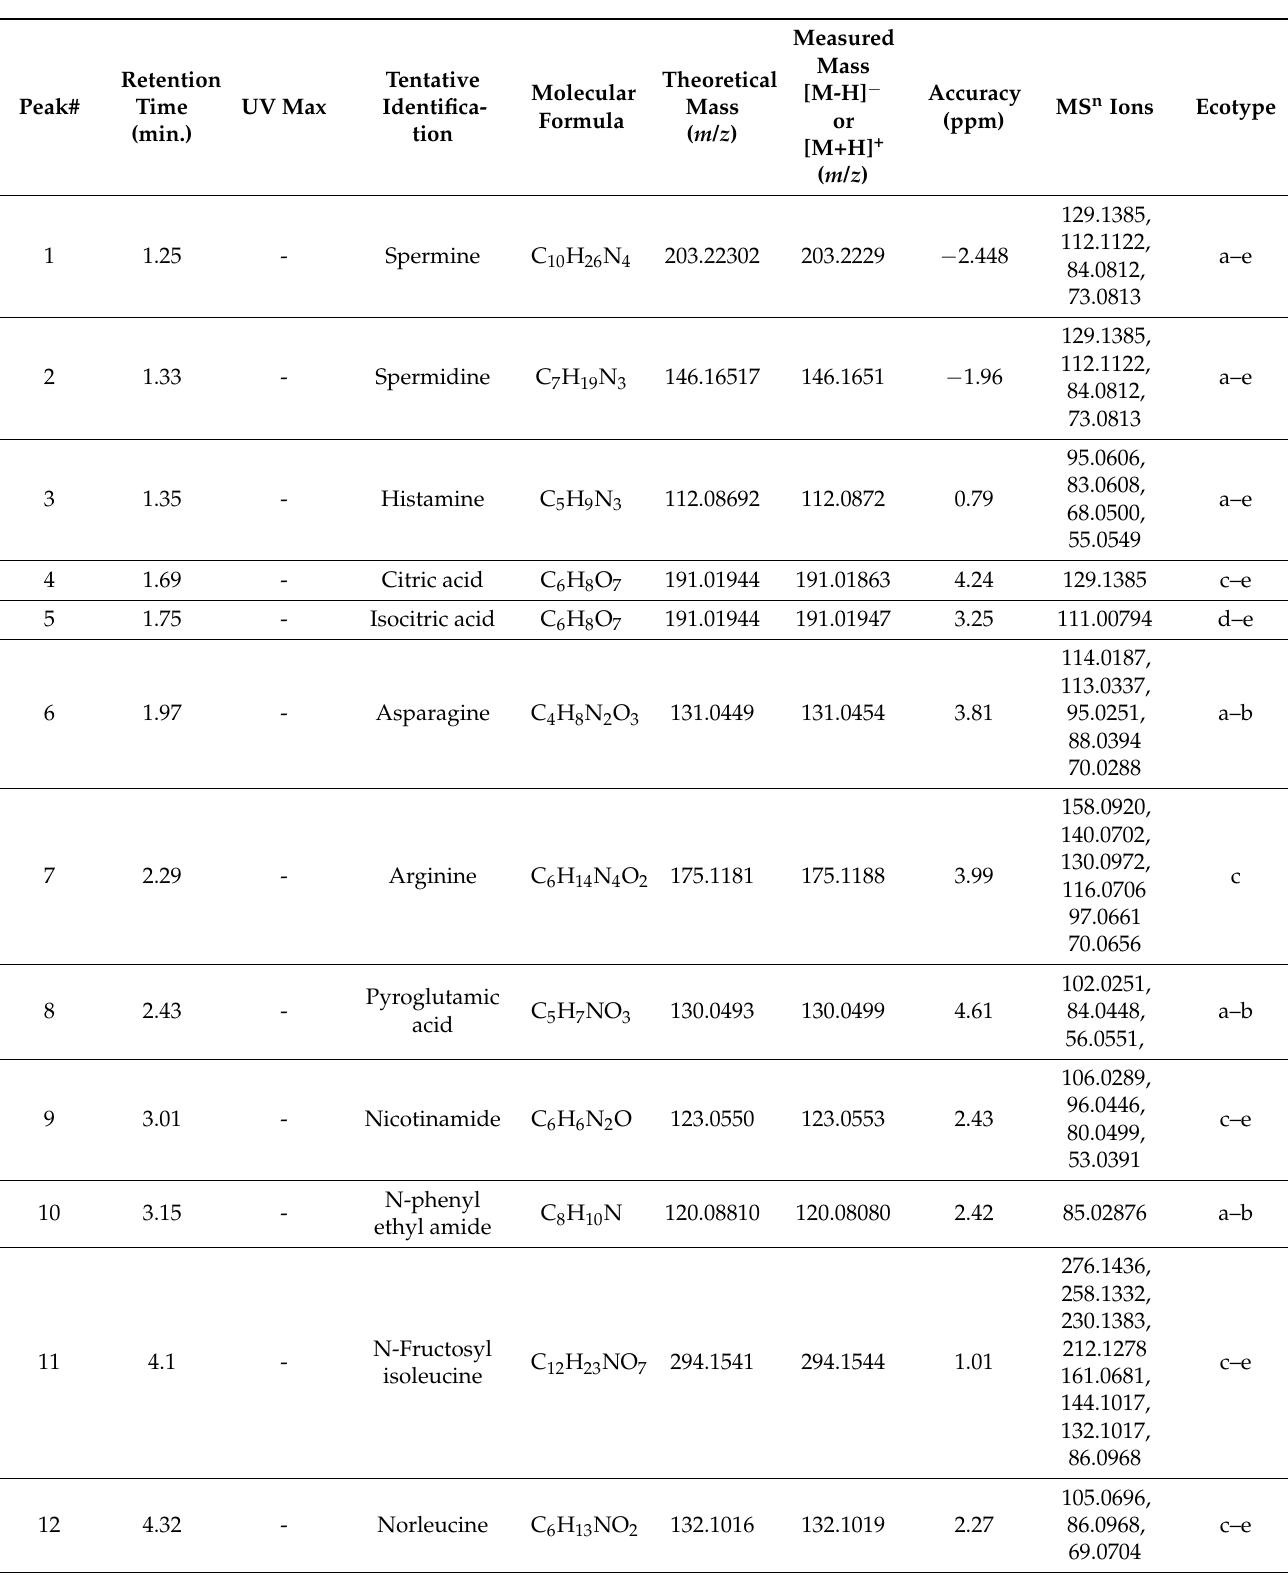
Table 3. High resolution UHPLC-PDA-ESI-OT-MS identification of metabolites in fractions of cocona fruits (a–e): NMA1, SRN9, CD1, CTR, UNT2 ecotypes,